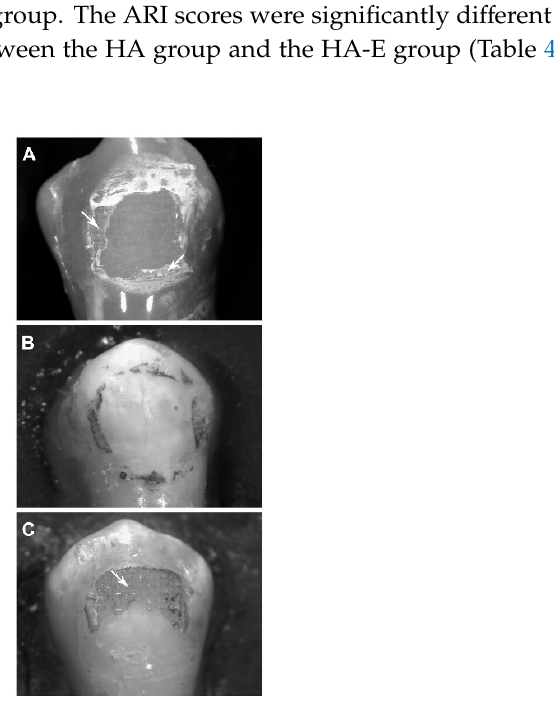
Table 3. Tukey’s post hoc comparison between groups ( n = 10).